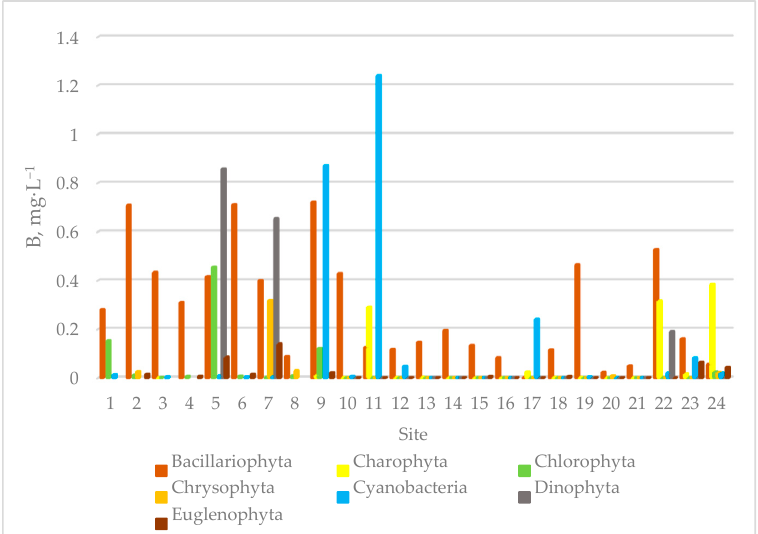
Figure 6. Biomass of phytoplankton cells in divisions within the Ukrainian part of the Siversky Donets river basin. Table 5. Dominant species of algae according to biomass values in the Siversky Donets river basin. Species